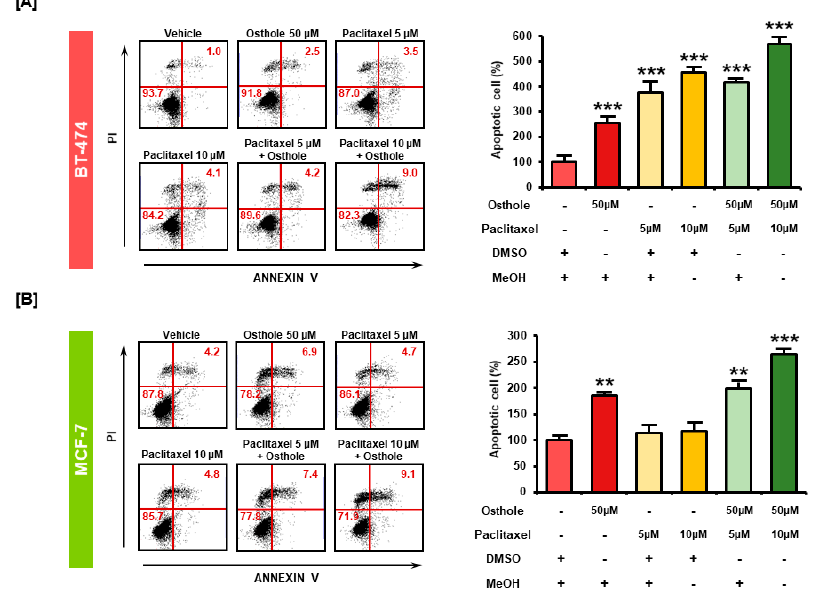
Figure 8. Combinational apoptotic effect of osthole and conventional chemotherapeutic agents. The proportion of apoptotic cells following treatment with osthole with and without paclitaxel was detected using Annexin V/PI staining in BT-474 ( A ) and MCF-7 ( B ). BT-474 and MCF-7 cells were incubated with osthole, paclitaxel, or a combination of both for 48 h. Data are represented in the graph as the percentage of apoptotic cells compared with vehicle-treated control (100%). All experiments were performed in biological triplicate and the asterisks indicate statistically significant differences compared to Vehicle-treated control (** p < 0.01 and *** p < 0.001).